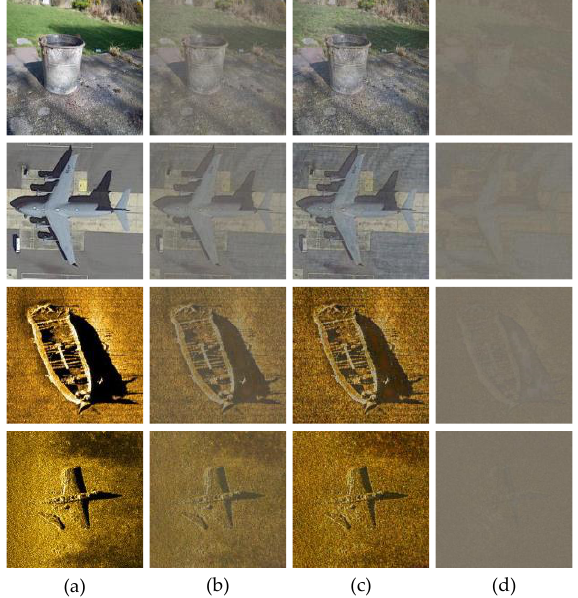
Figure 7. Results of decoding the low-frequency and high-frequency of deep feature: ( a ) is the original input image, ( b ) is the reconstruction image of whitening transform, ( c ) is reconstruction image of the low-frequency feature, and ( d ) is reconstruction image of the high-frequency